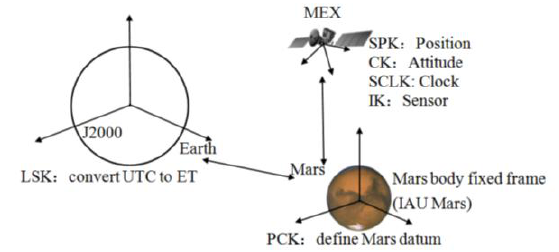
Figure 2. Transformation of time and coordinates using SPICE kernels